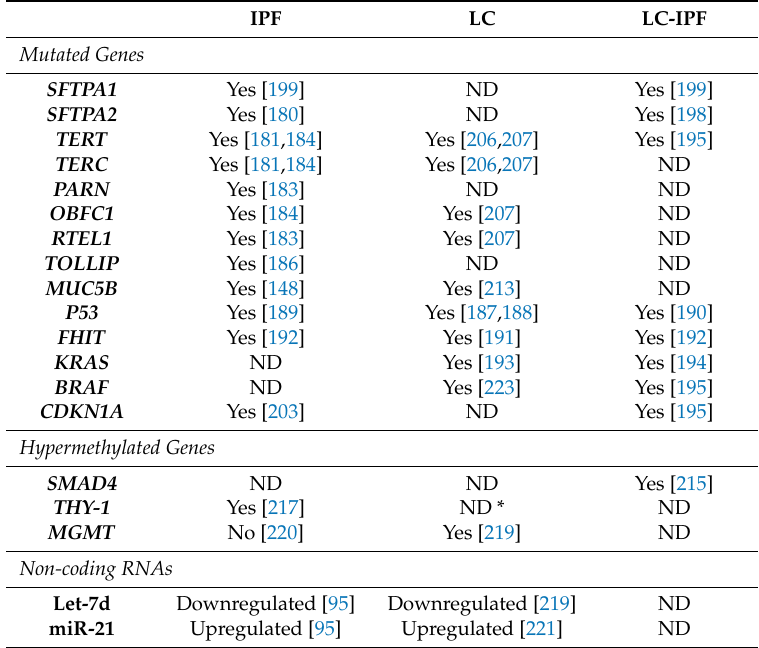
Table 4. Mutated genes, hypermethylated genes, and non-coding RNAs with altered expression in Idiopathic pulmonary fibrosis (IPF), lung cancer (LC), and LC-IPF